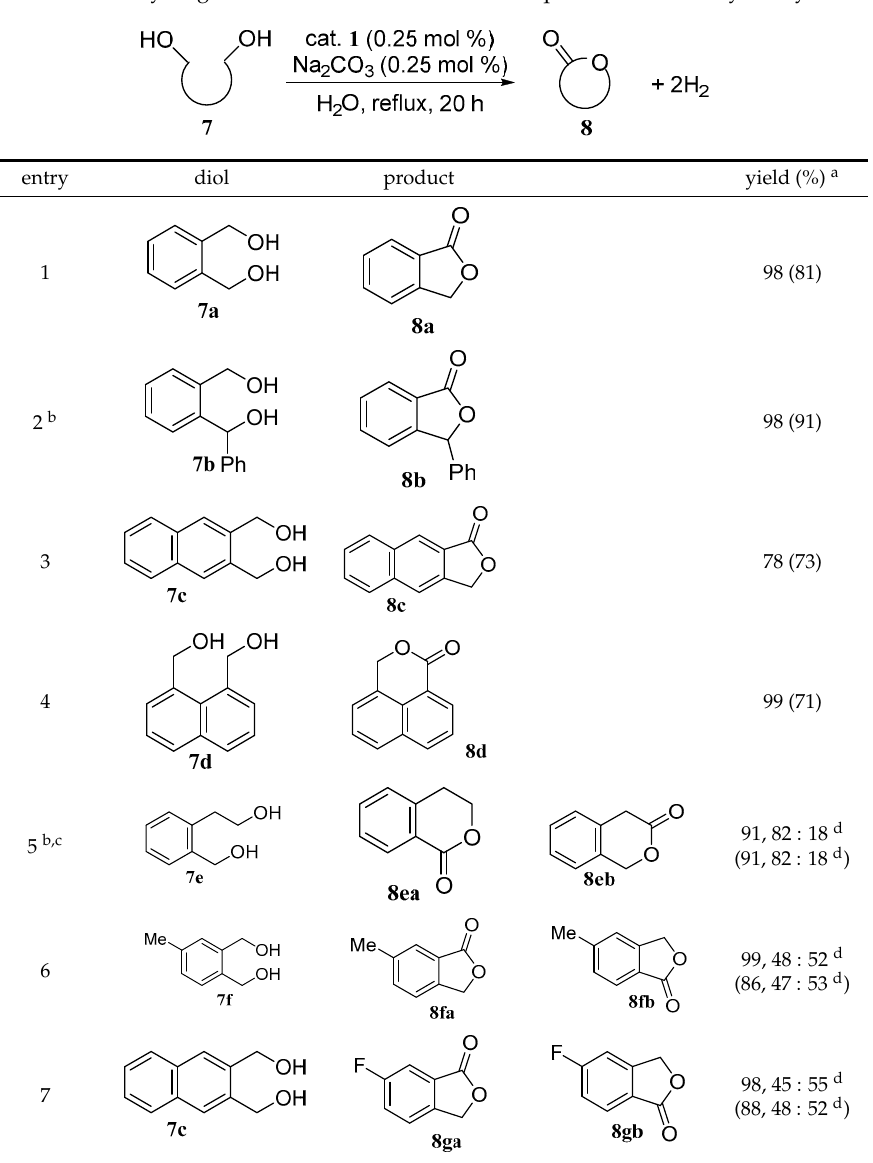
Table 4. Dehydrogenative lactonization of diols in aqueous media catalyzed by 1 .